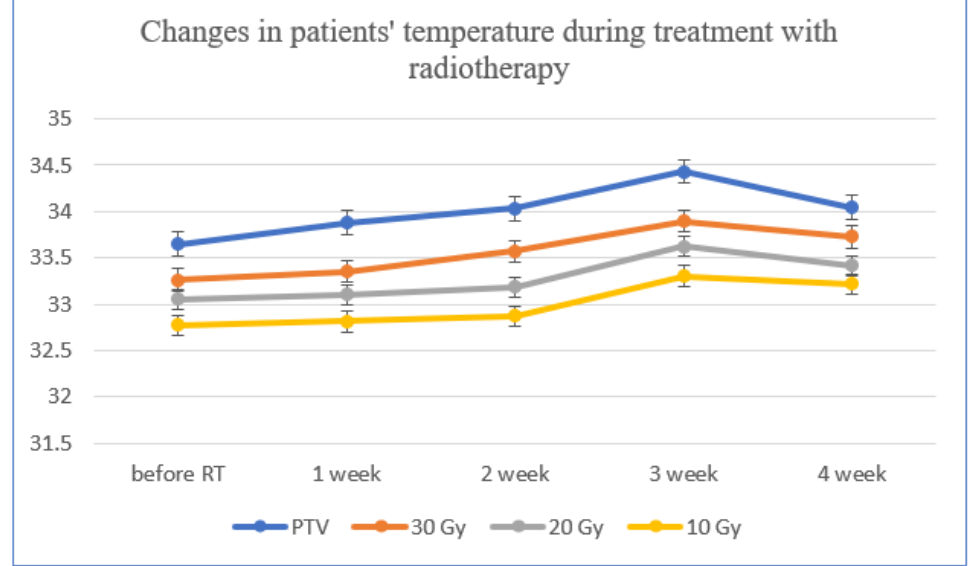
Figure 4. Average temperatures in the target area (PTV) and the isodose area of 30 Gy, 20 Gy and 10 Gy for patients undergoing radiotherapy treatment.